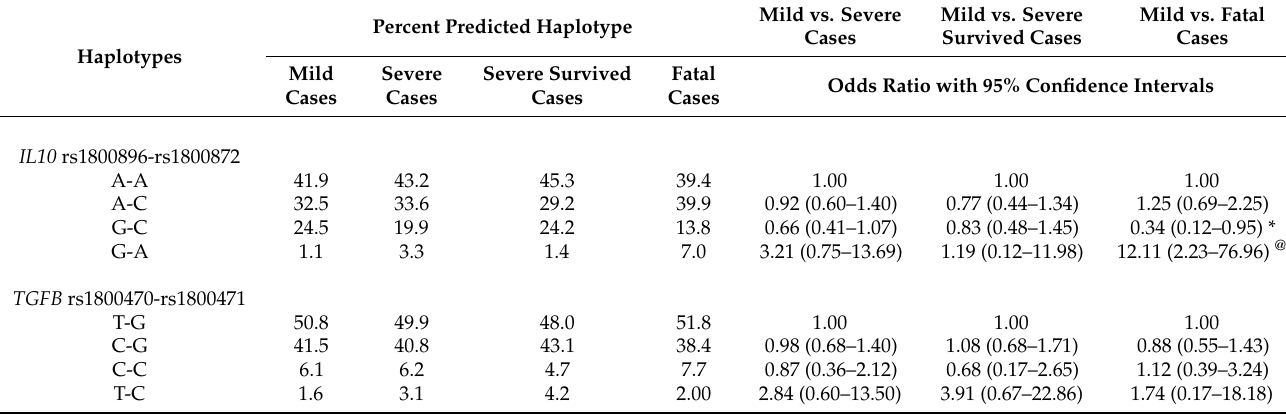
Table 4. Percent haplotype frequencies of IL10 and TGFB polymorphisms in influenza A(H1N1)pdm09 patient groups.